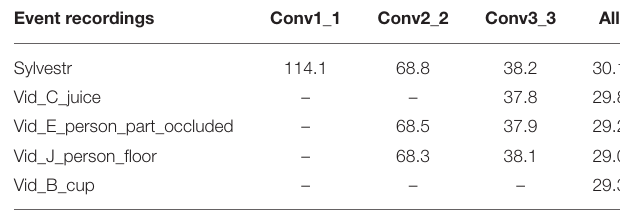
TABLE 3 | Tracking speed under different convolutional layers of the employed network.